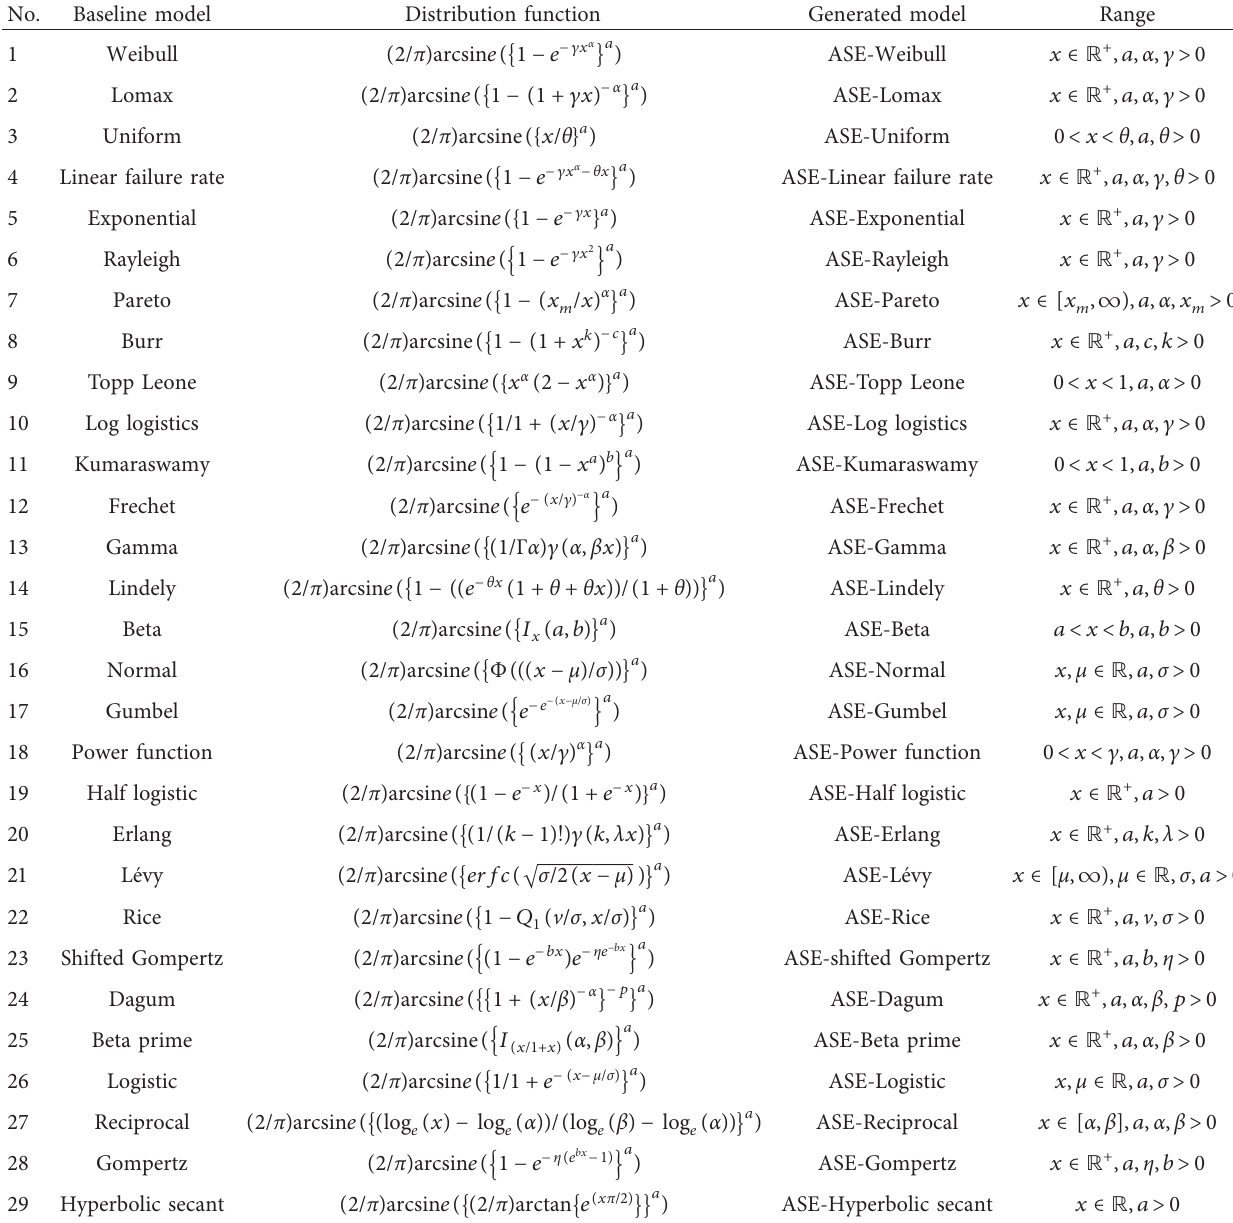
Table 1: New contributed submodels based on the ASE-X